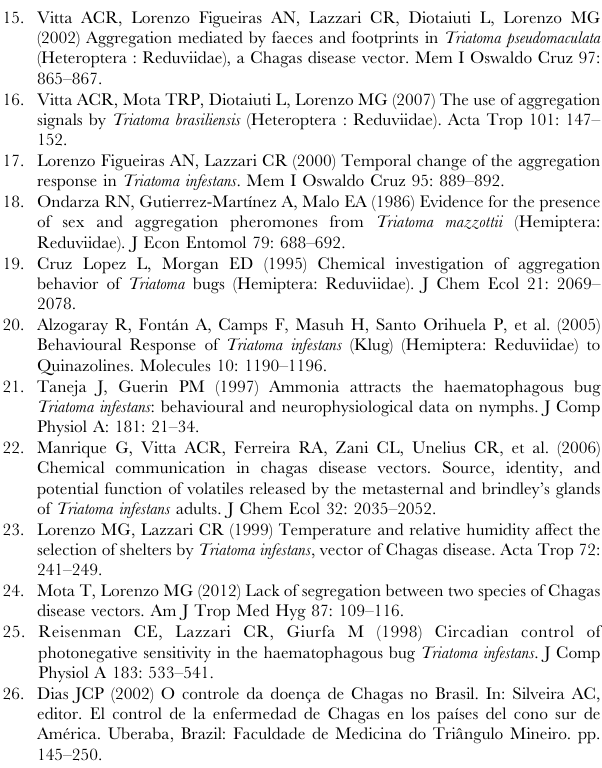
Figure 3. Recruitment of bugs to shelters baited with synthetic blends. Mean number of larvae of A- T. infestans , B- P. megistus and C- T. brasiliensis found inside experimental and control shelters after overnight assays in which mixtures of 16 ng, 160 ng or 1.6 m g of each compound were tested in association with one (test shelter) of two shelters offered. Error bars represent the standard errors of the means. Asterisks indicate significant differences in Wilcoxon signed rank